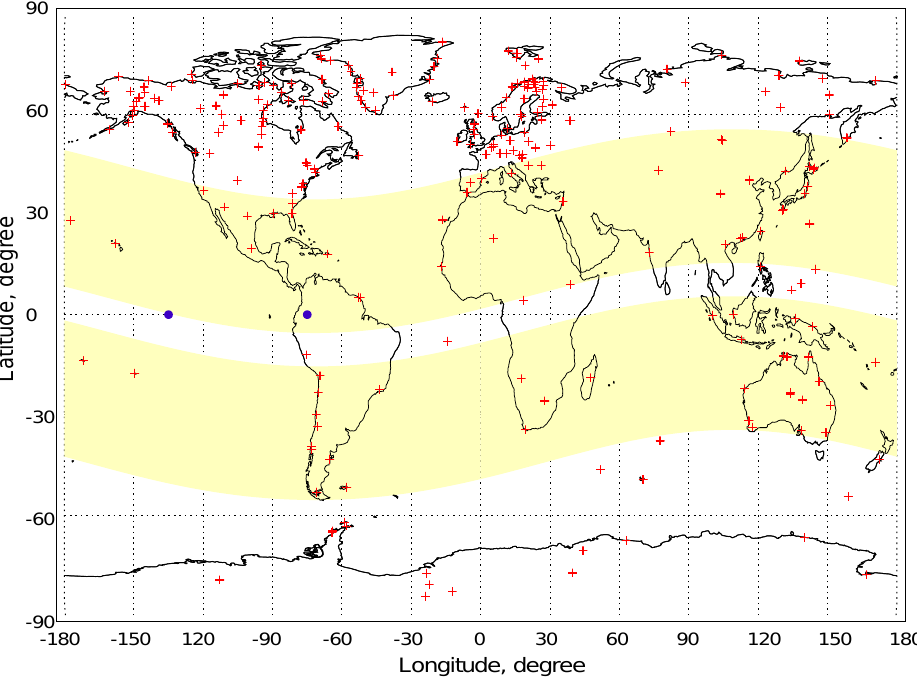
Fig. 7. Global distribution of the locations of ground magnetometers in geographic coordinate system. Each magnetometer is marked as a red plus sign. The mid-latitude regions in corrected magnetic coordinate system (–45 ◦ ≤ θ cgm ≤− 5 ◦ and 5 ◦ ≤ θ cgm ≤ 45 ◦ ) are shown as light yellow shaded area. Eastern GOES and western GOES are illustrated as blue dots in the